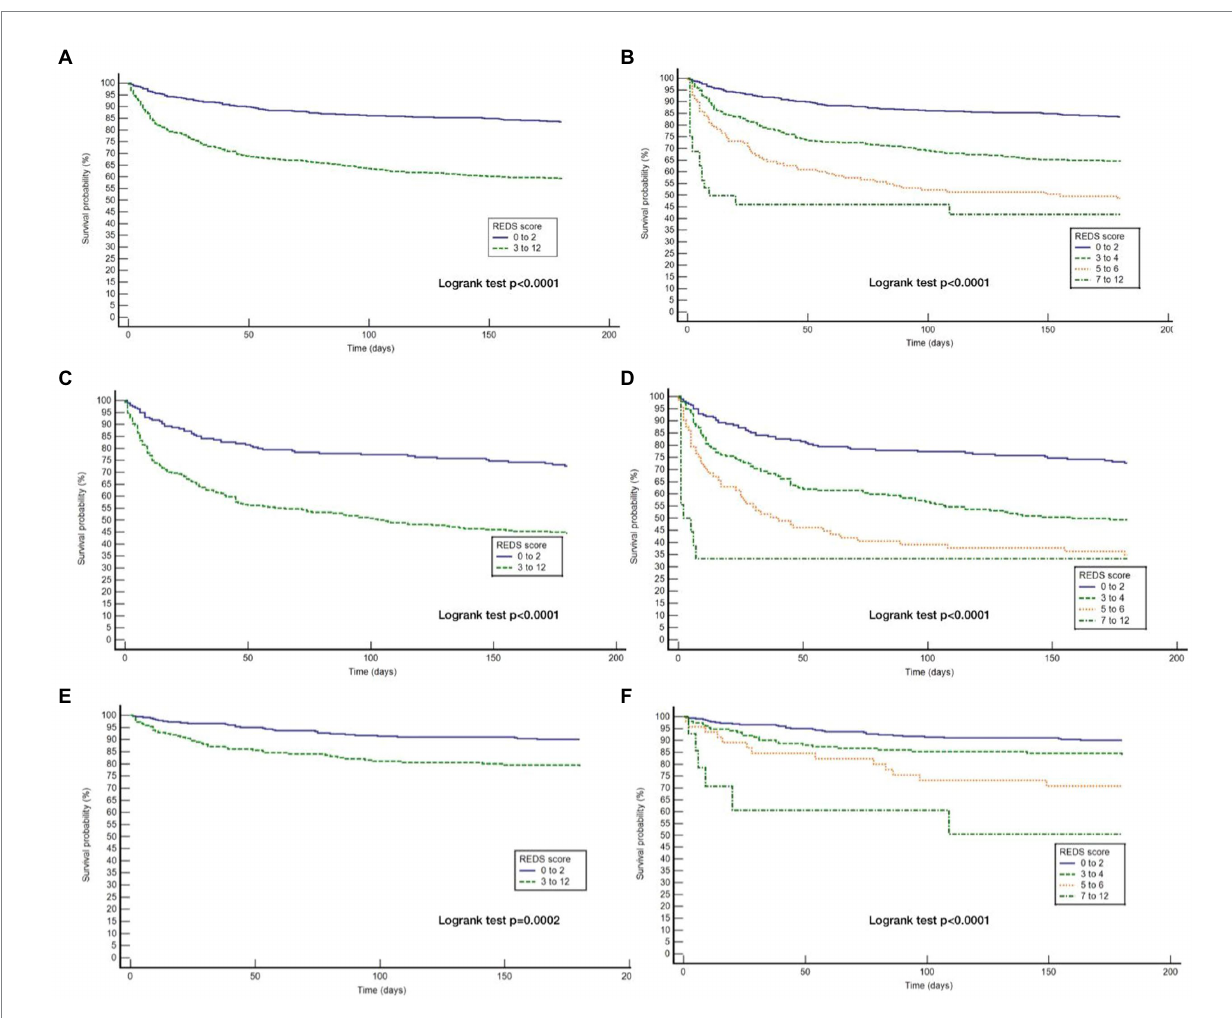
FIGURE 6 Kaplan Meier curves for 180 day survival for the whole study population and those with and without the specified* co-morbidities by REDS score band. *Specified comorbidities = presence of any one of the following: dementia, malignancy, care home residency or a minimum three times a day care package, on long-term oxygen therapy (LTOT) or a previous do-not-resuscitate decision (A) Kaplan Meier curves for the study cohort stratified by REDS score of 0–2 and 3–12; (B) Kaplan Meier curves for the study cohort stratified by REDS score of 0–2, 3–4, 5–6 and 7–12; (C) Kaplan Meier curves for those WITH the specified comorbidities stratified by REDS score of 0–2 and 3–12; (D) Kaplan Meier curves for those WITH the specified comorbidities stratified by REDS score of 0–2, 3–4, 5–6 and 7–12; (E) Kaplan Meier curves for those WITHOUT the specified comorbidities stratified by REDS score of 0–2 and 3–12; (F) Kaplan Meier curves for those WITHOUT the specified comorbidities stratified by REDS score of 0–2, 3–4, 5–6, and